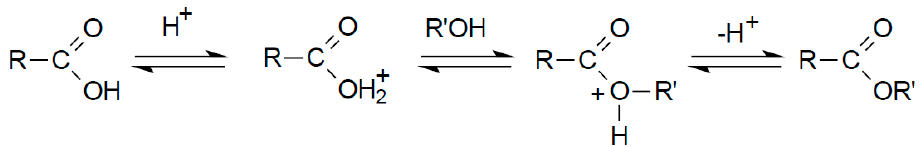
Figure 1. Schematic reaction esterification of fatty acids by acid catalyst [27].